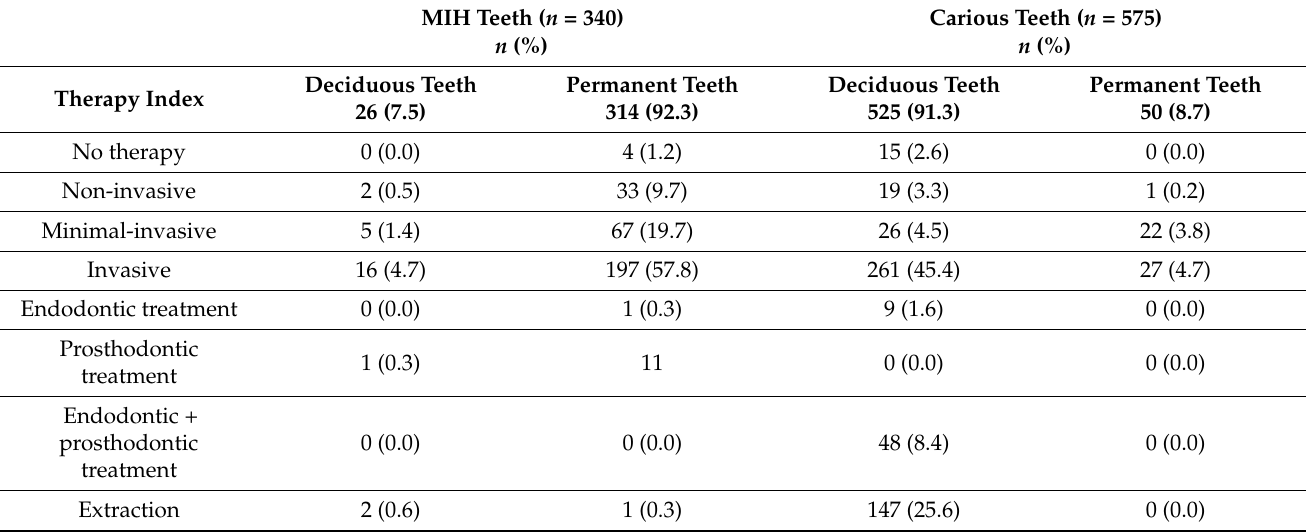
Table A1. Overview of the Therapy Score and Treated Teeth in the MIH and Caries Group.